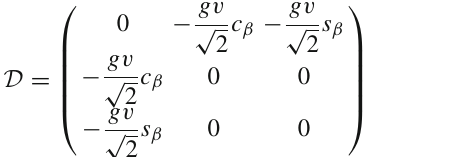
of the bottom-quark self-energy b , 2 . The crossed lines indicate off-diagonal propagator contributions 1